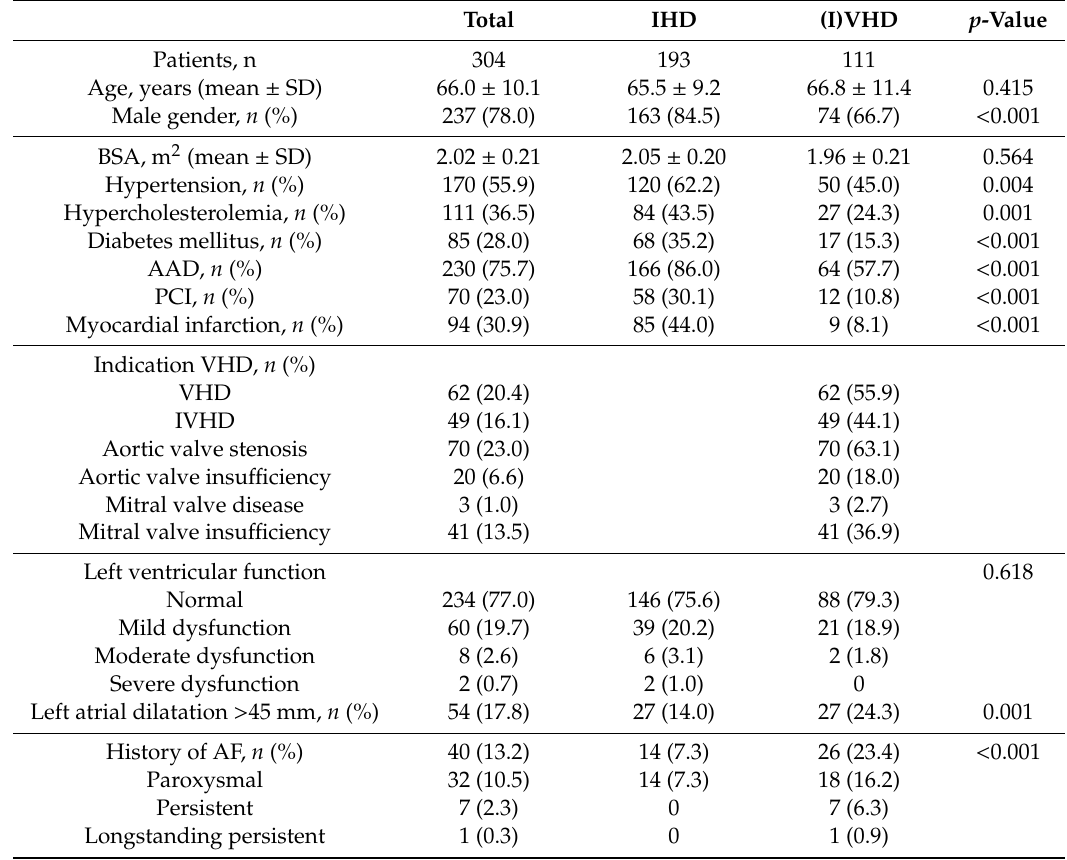
Table 1. Patient